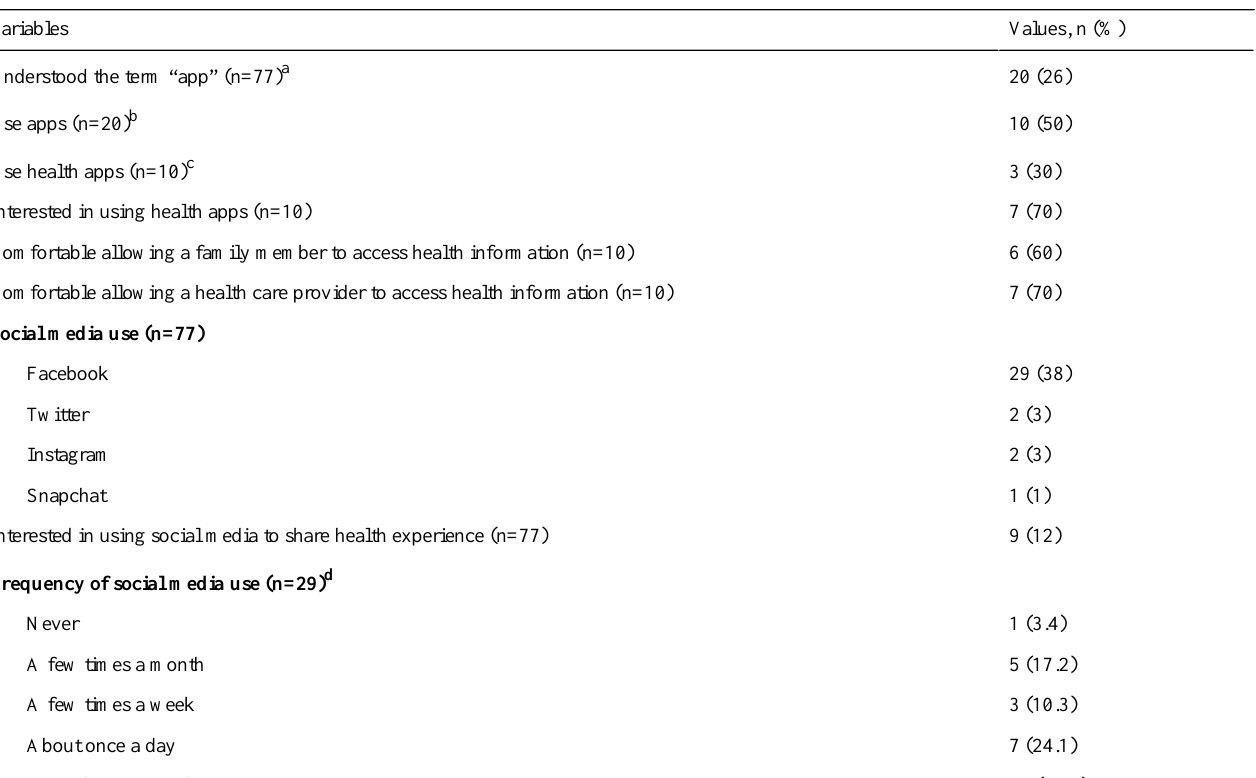
Table 4. Mobile health technology use.